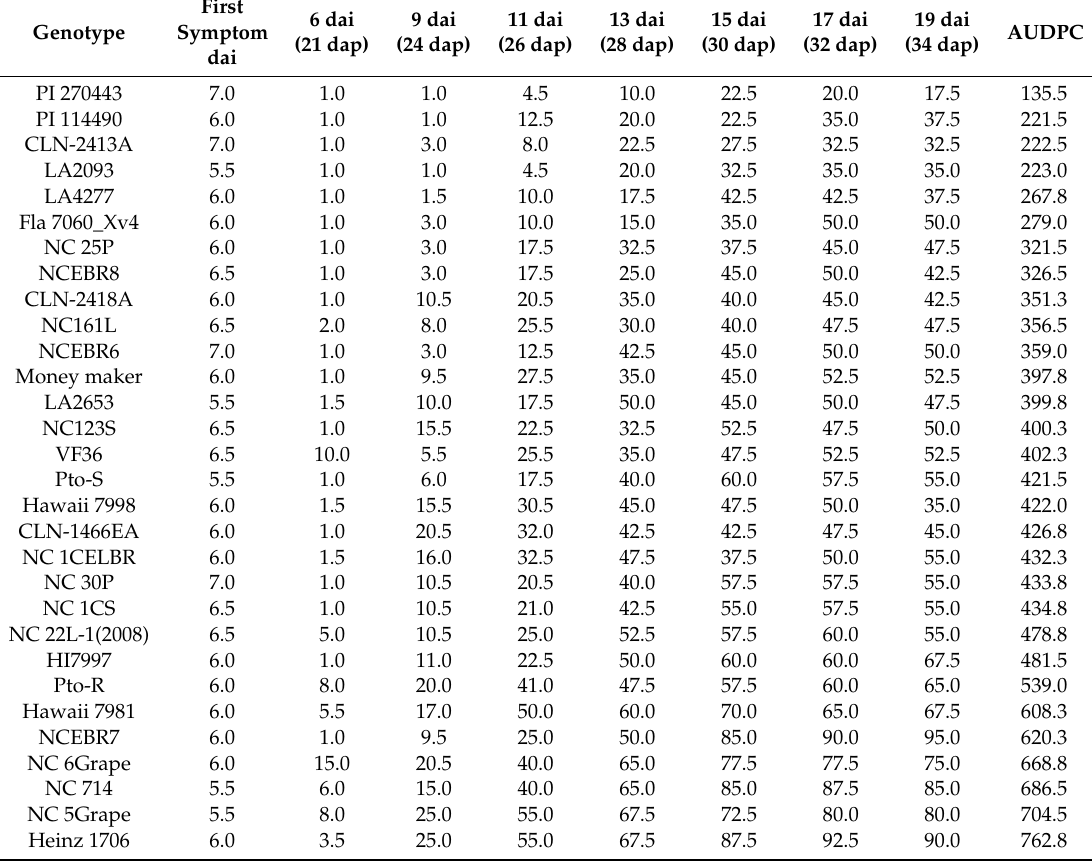
Table 1. Bacterial spot disease development in the tomato breeding lines. Tomato plants were inoculated 15 days after planting (dap). While the first symptom was observed on di ff erent days in di ff erent lines, we started scoring the lines for bacterial spot (BS) six days after inoculation (dai) of the plants and scored in every two days interval. Data presented in percentage. Last column has the area under disease progress curve (AUDPC) data, which can be used as a single indicator in disease screening.